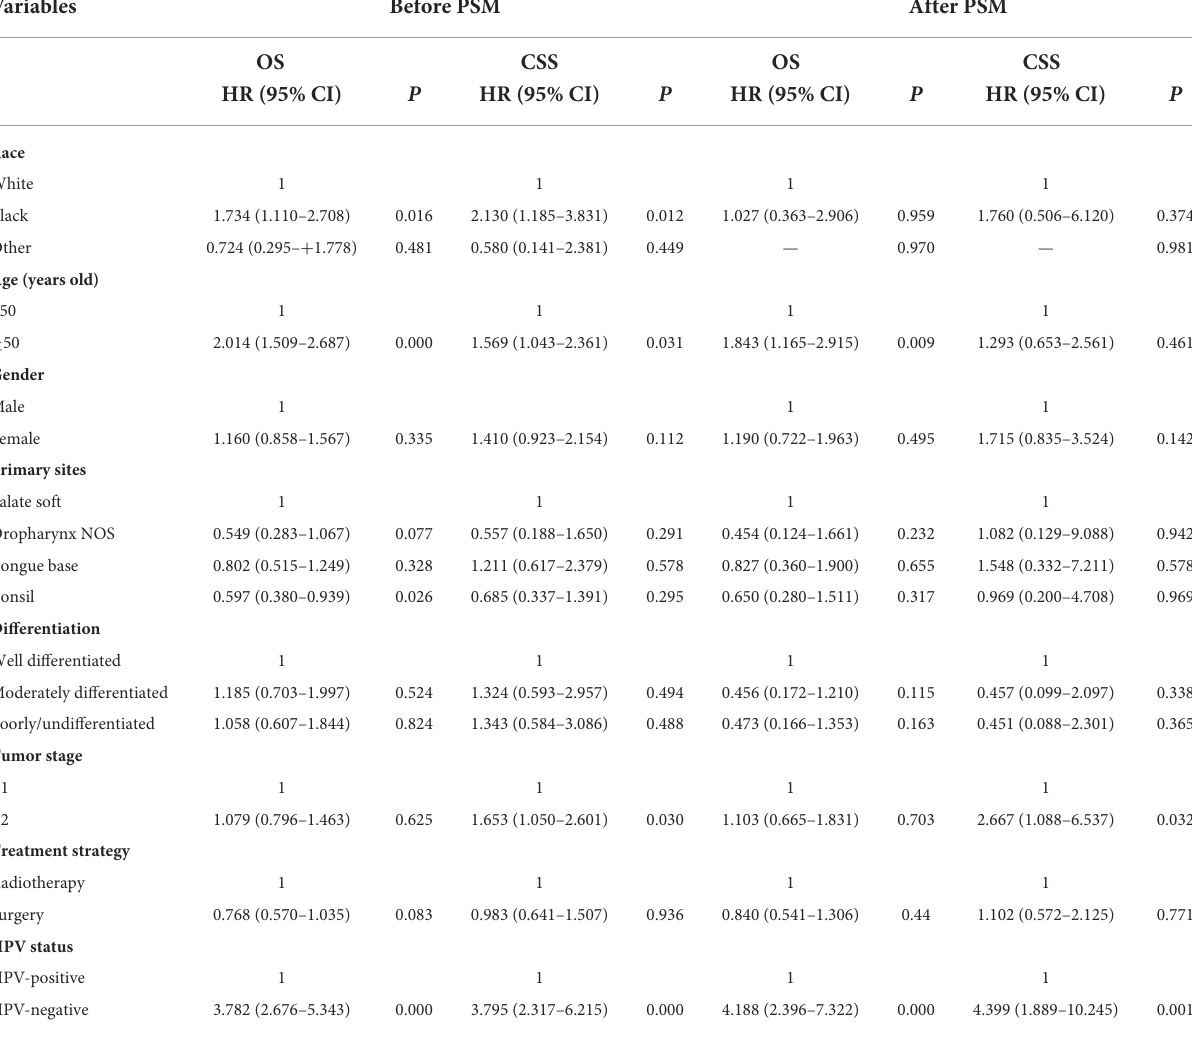
TABLE 3 Multivariate Cox analysis for overall survival and cancers specific survival before and after propensity matching